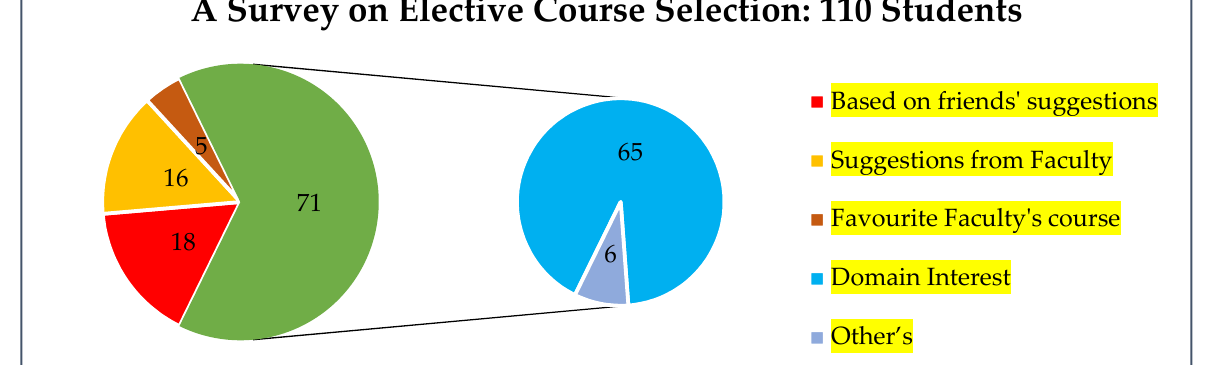
Figure 1. A survey on the selection of elective courses.